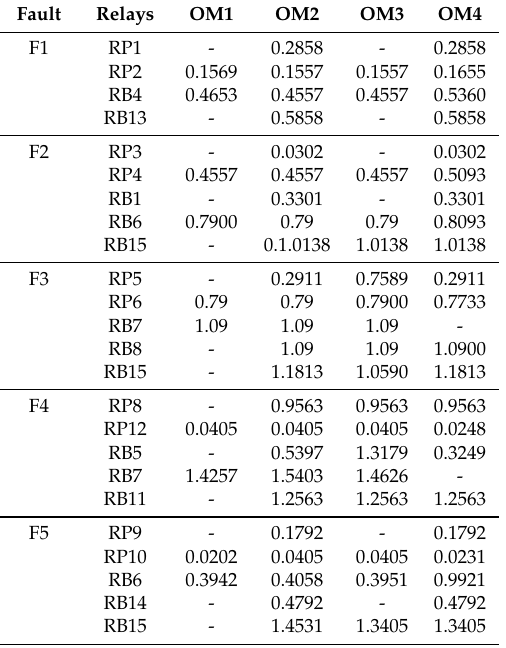
Table 13. Operation times for all operational modes (OMs) with a single set of